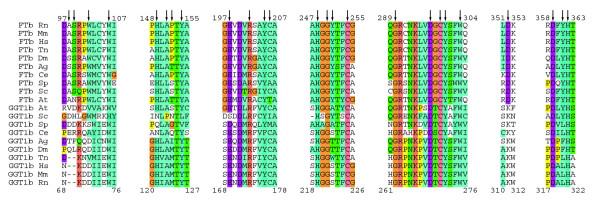
Alignment of FT and GGT1 beta subunits (FTb, GGT1b) in the regions of binding-pocket residues (marked with arrow) using ClustalX [57]. Residue ranges shown above and below correspond to the numbering in the PDB structures of rat FT beta (PDB 1D8D) and GGT1 beta (PDB 1N4Q), respectively. Accession numbers are as follows (GenBank unless indicated otherwise): Hs (Homo sapiens) FTb, NP_002019; GGT1b, NP_005014; Mm (Mus musculus) NP_666039; NP_766215; Rn (Rattus norvegicus) PDB 1D8D; 1N4Q; Tn (Tetraodon nigroviridis) CAG09215; CAF904630; Dm (Drosophila melanogaster) NP_650540; NP_525100; Ag (Anopheles gambiae) XP_321357; XP_317045; Ce (Caenorhabditis elegans) NP_506580; NP_496848; At (Arabidopsis thaliana) NP_198844; NP_181487; Sp (Schizosaccharomyces pombe) NP_594251; NP_594142; Sc (Saccharomyces cerevisiae) P22007; NP_011360. Standard ClustalX coloring (according to conserved amino acid type).